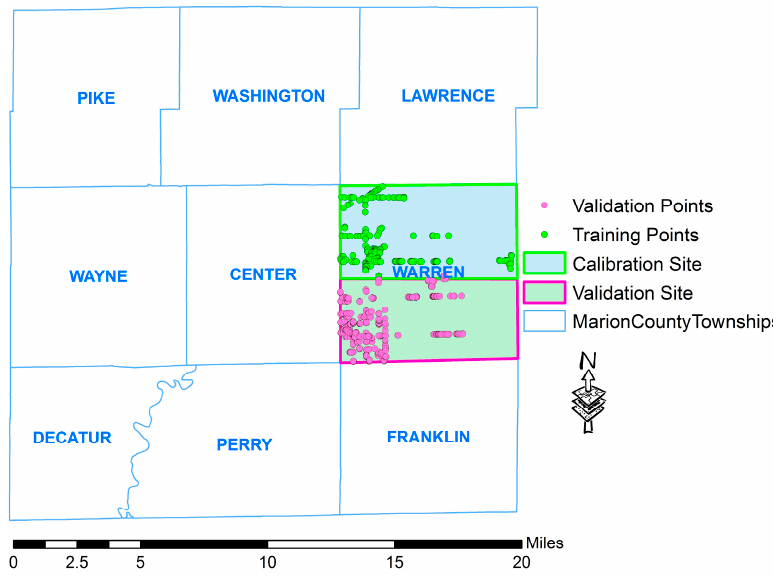
Figure 3. The calibration and validation sites.